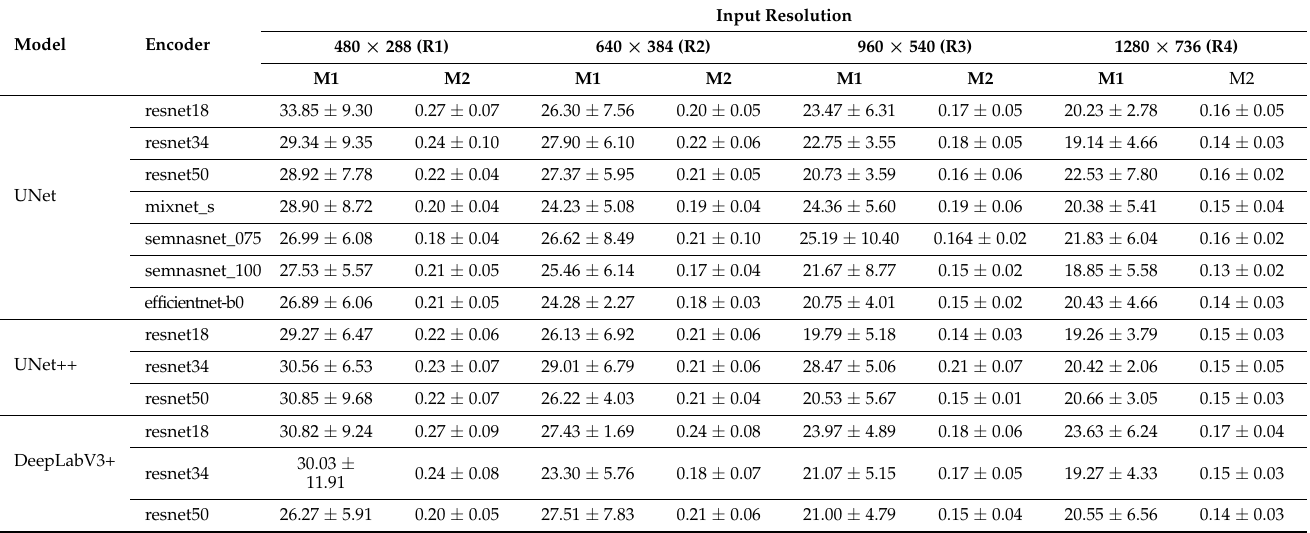
Table 4. Metrics for researched crowd-counting